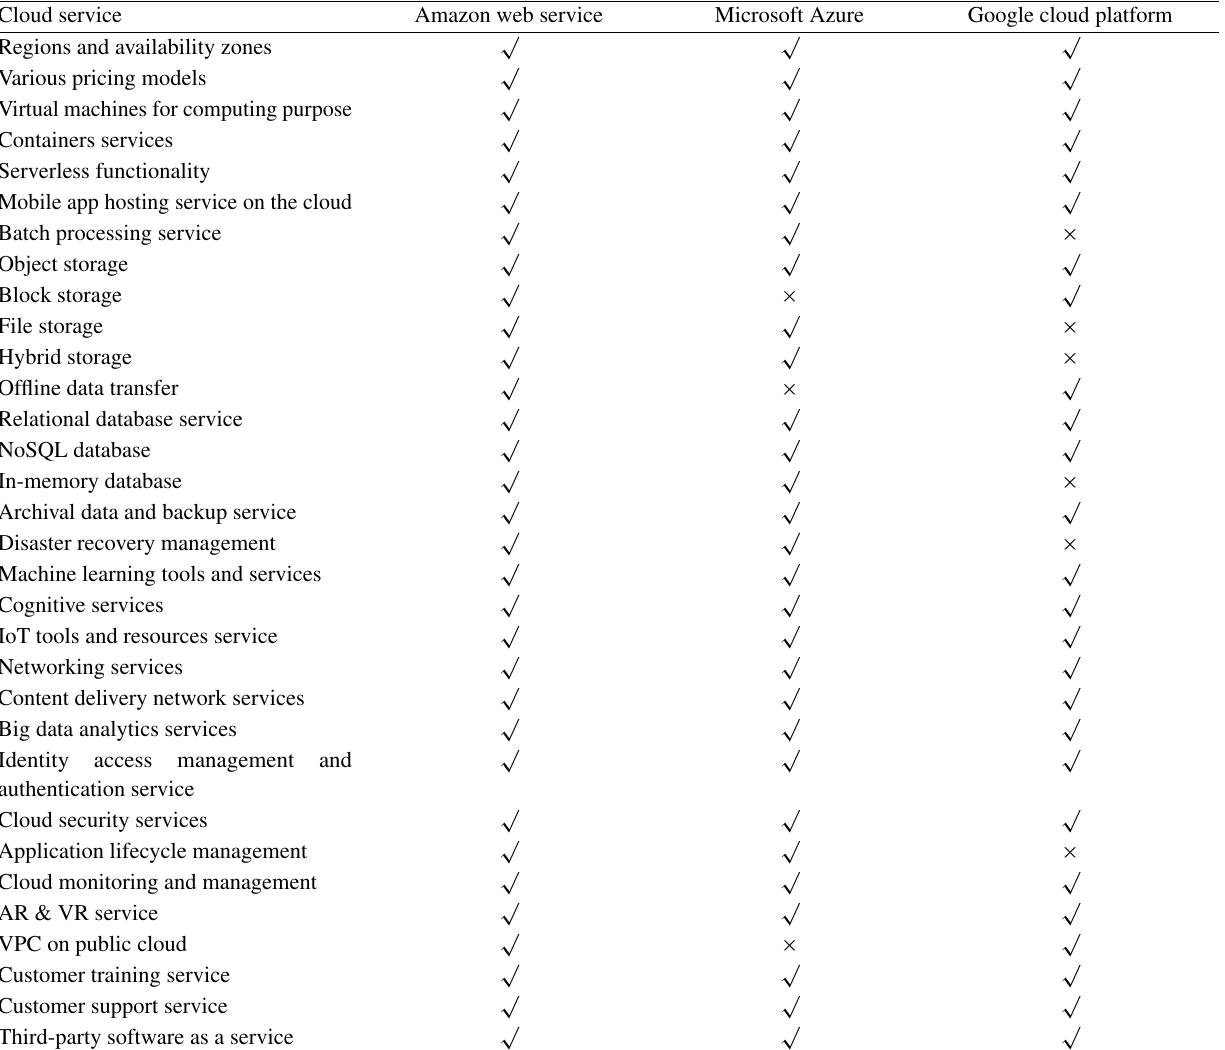
Table 10 Comparison of the availability and non-availability of services offered by the top three